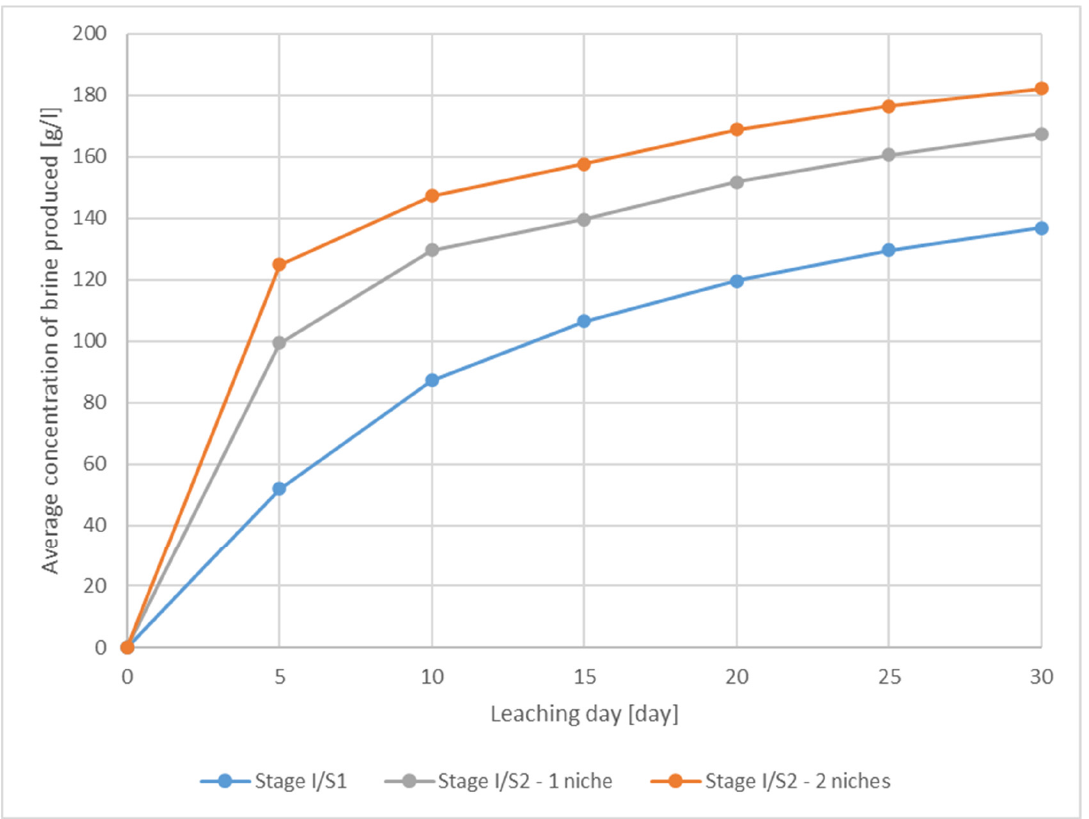
Figure 10. Comparison of changes in the brine concentration of the produced brine for Stage I—the first 30 days for different scenarios.